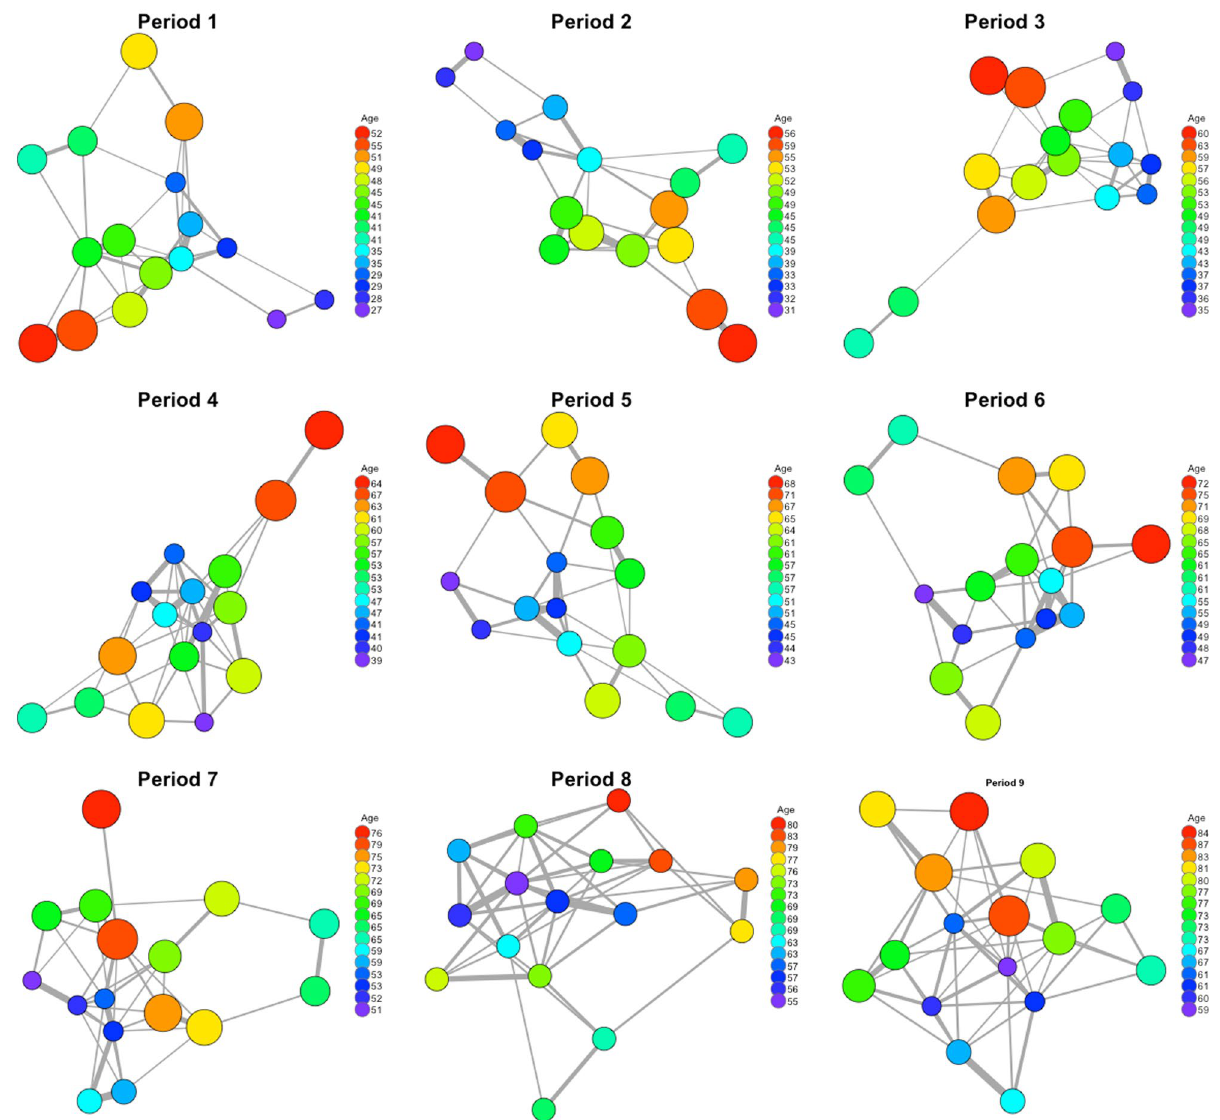
Figure 2. Visualisation of the networks generated for cohort 4 for the first 9 periods of 4-days. The size of the circle represents the age of the calf whereas the thickness of the line represents the edge weight (association index) between two nodes